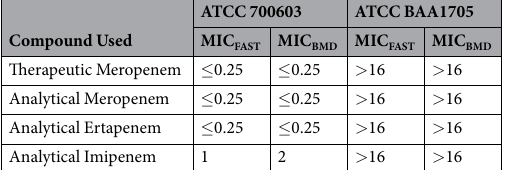
Table 3. Control K. pneumoniae strains exposed to carbapenems produced concordant results between broth microdilution and FAST. The ATCC control carbapenem susceptible (ATCC 700603) and control carbapenem resistant (ATCC BAA1705) K. pneumoniae strains were exposed to three carbapenems, across the limited clinical screen configuration of concentrations. There were no differences (outside the resolution of the broth microdilution test) in MIC FAST and MIC BMD